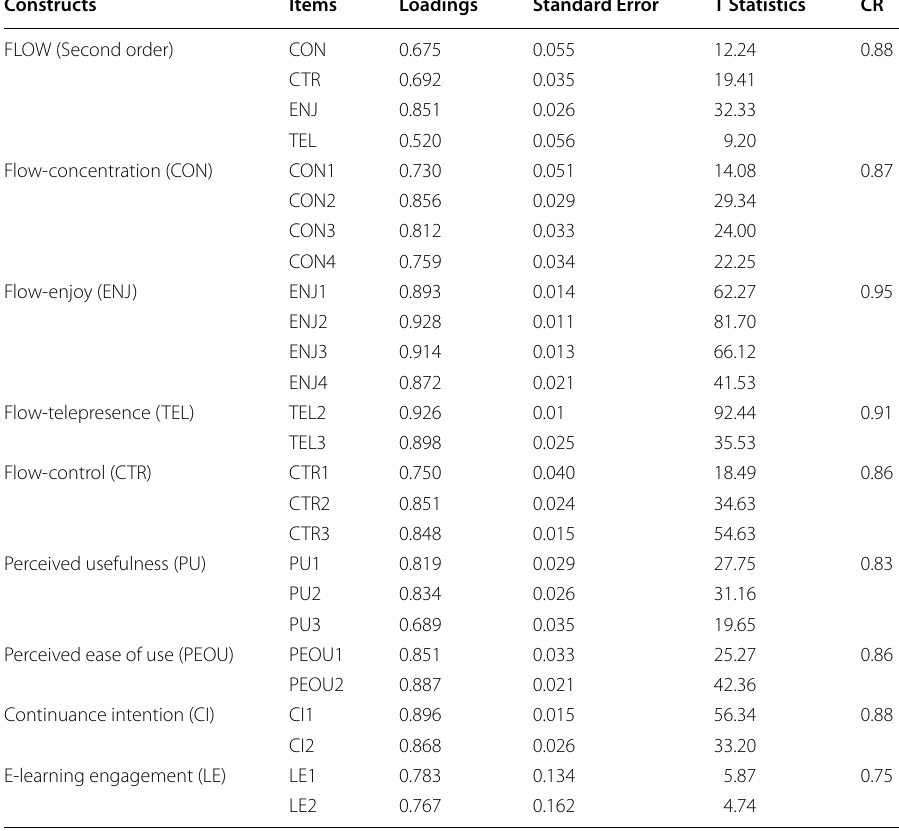
Table 3 Construct validity measured by items loading and reliability measured by composite